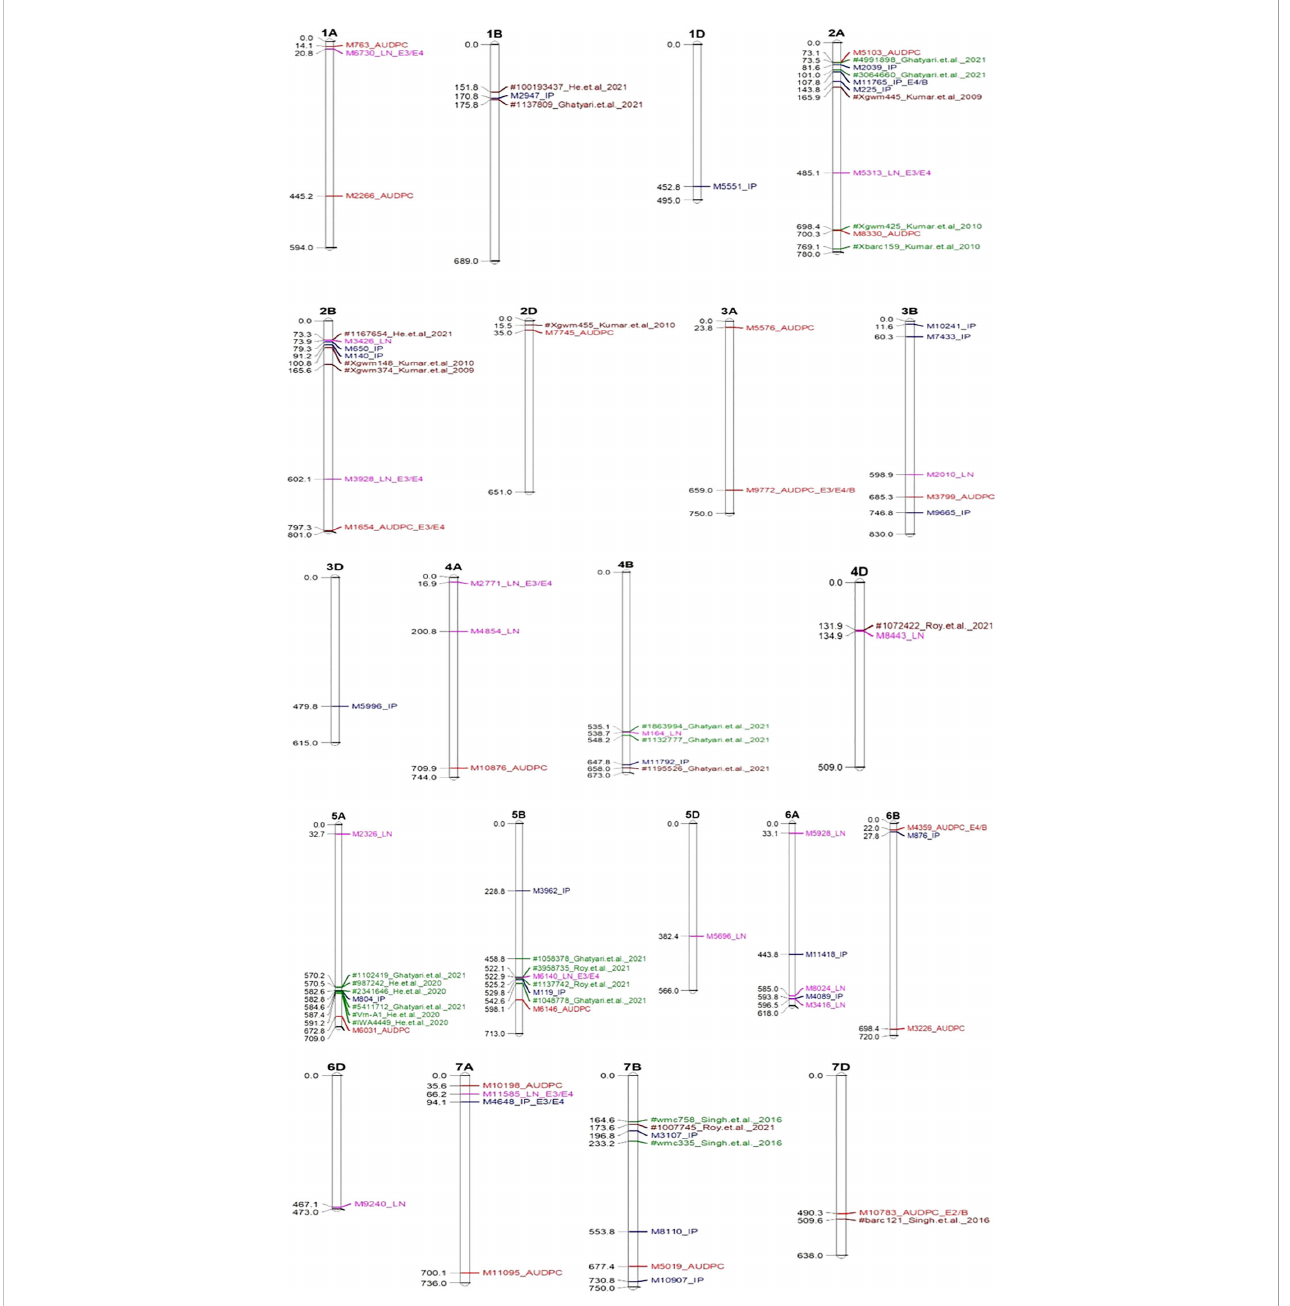
FIGURE 5 Signi fi cant MTAs associated with QTLs reported earlier (Green and Brown colour) mapped on different chromosome. In the above fi gures signi fi cant MTAs for AUDPC indicated by red colour; IP by blue colour & LN by pink colour; E1-Enivironment 1; E2-Enivironment 2; E3-Enivironment 3; E4- Enivironment 4;